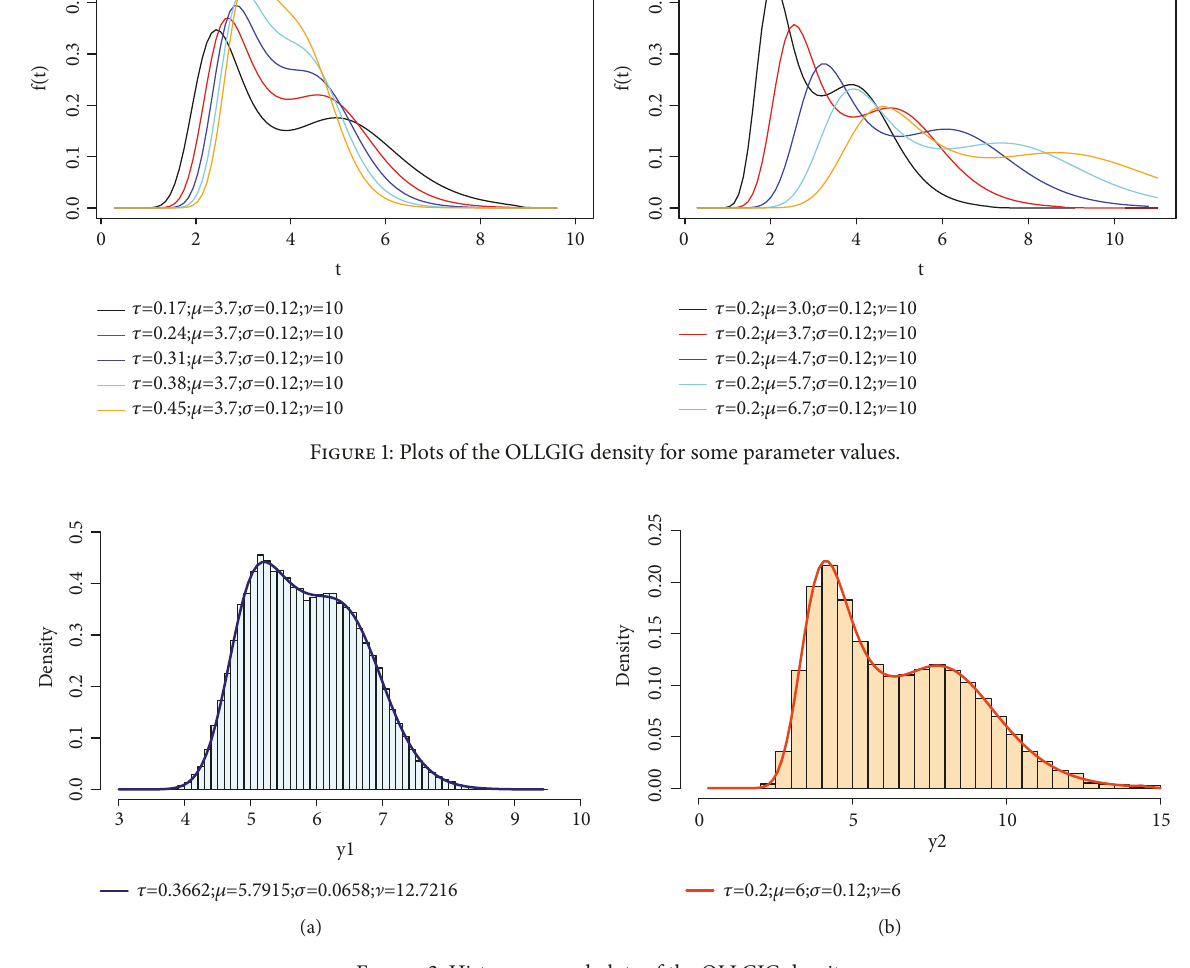
Figure 2: Histograms and plots of the OLLGIG